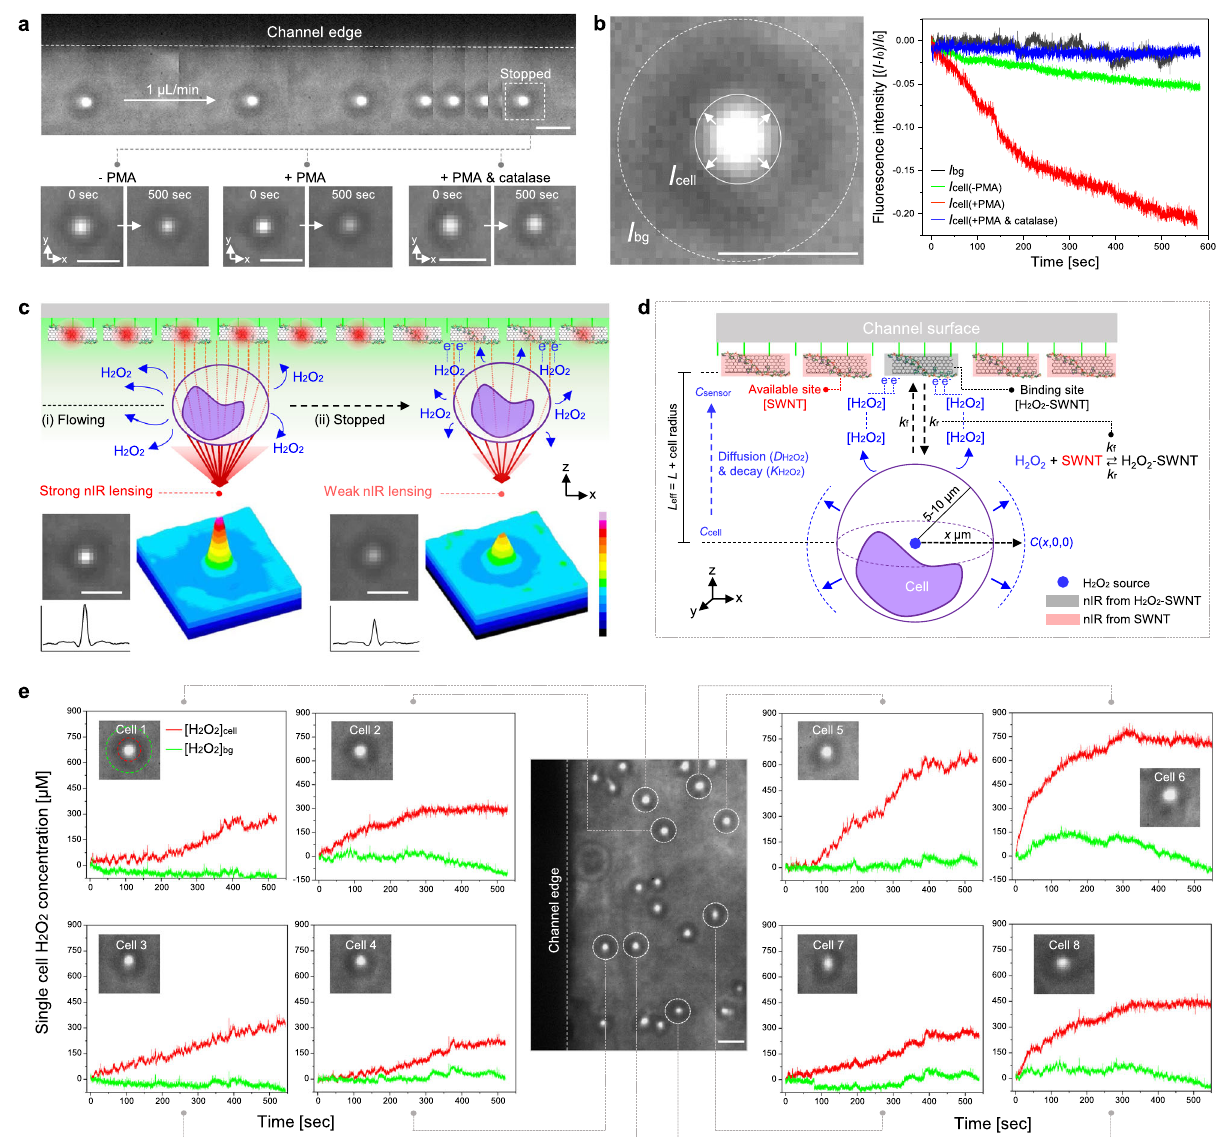
Fig. 4 Real-time chemical ef fl ux monitoring using the cellular lensing effect. a Time-series nIR images of a stationary single monocyte with different immune activation states ( − PMA, + PMA, + PMA & catalase). b Real-time nIR intensity variations of the cells with different activation states. c Schematic illustrations of H 2 O 2 ef fl ux monitoring mechanism with nIR lensing effect. d 3D diffusion and reaction kinetic modeling for translation of measured nIR signals to real-time local H 2 O 2 concentration. e Real-time H 2 O 2 ef fl ux pro fi les of each single monocyte estimated by the model. 16-color scalebars represent nIR intensity from white (16833) to dark blue (0). Scale bars: 20 µ